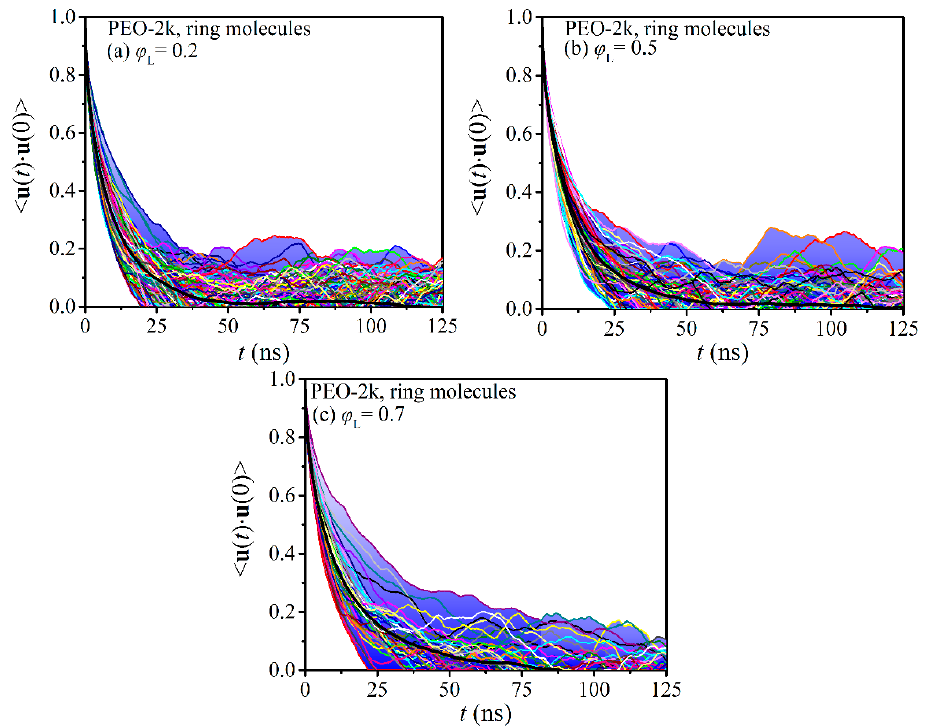
(cid:10) (cid:11) ( ) ( ) u ( t ) · u ( 0 ) for each ring PEO molecule separately ⋅ t 0 u u for each ring PEO molecule